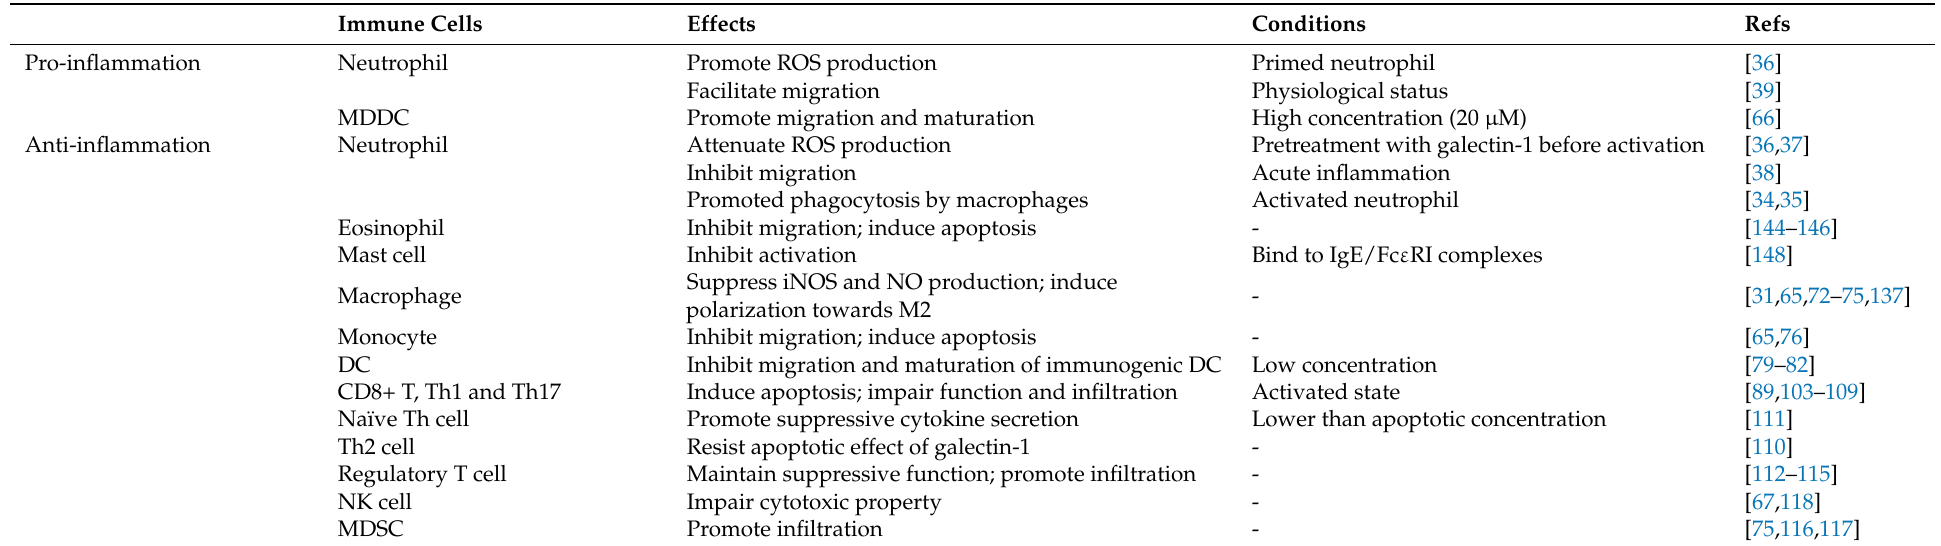
Table 3. Immunomodulatory effects of galectin-1 on immune